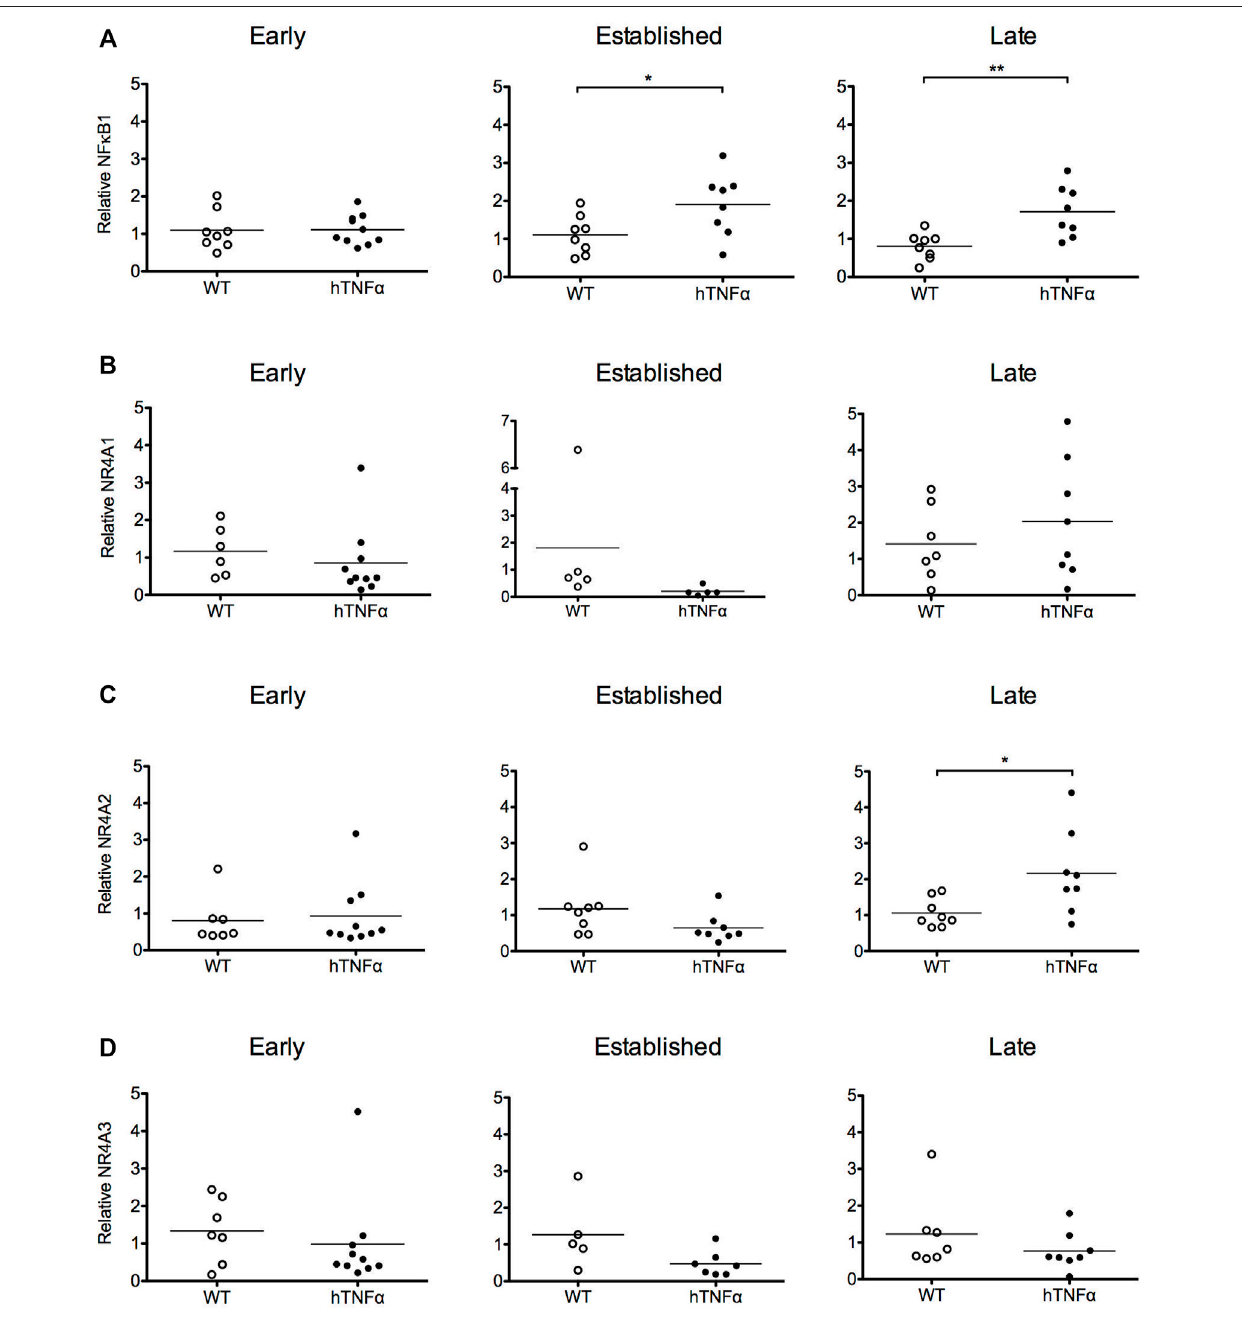
FIGURE 2 | Gene expression analysis of target transcription factors. RNA was extracted from the paws of wild-type and hTNF- α transgenic mice at early, established, and late timepoints. Relative levels of NF- κ B 1 (A) , NR4A1 (B) , NR4A2 (C) , NR4A3 mRNA (D) were measured by RT-qPCR and normalized to TBP. Horizontal bars represent mean expression levels for each group. Mann Whitney test, * p < 0.05, ** p < 0.005.